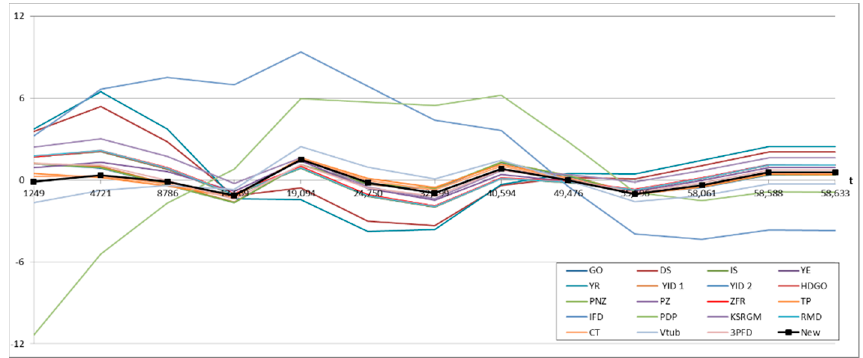
Figure 6. Relative error value for all models in Table 1 for dataset #2.